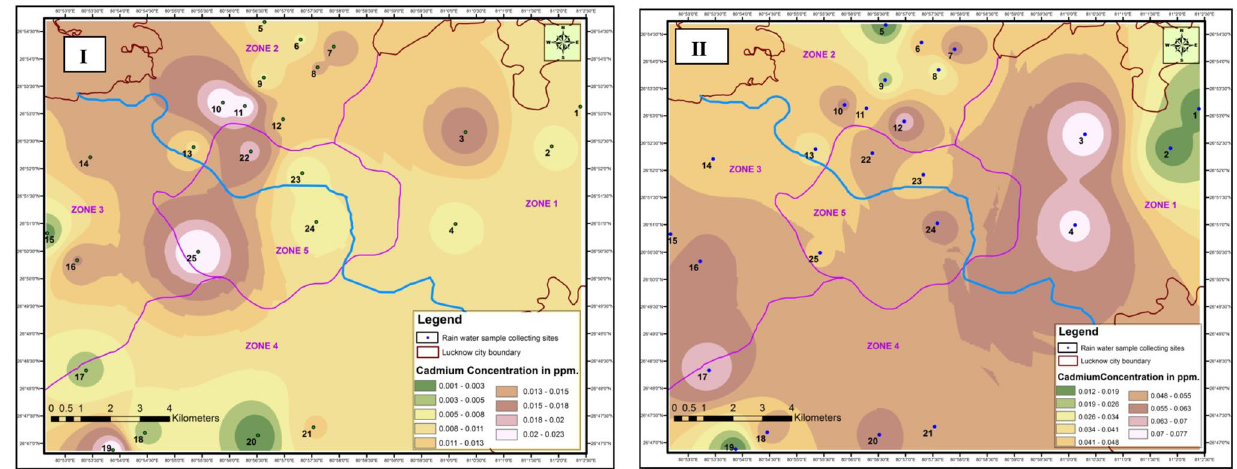
Fig. 6 Contour map of cadmium values at five zones of Lucknow city during first (I) rainfall and second(II)